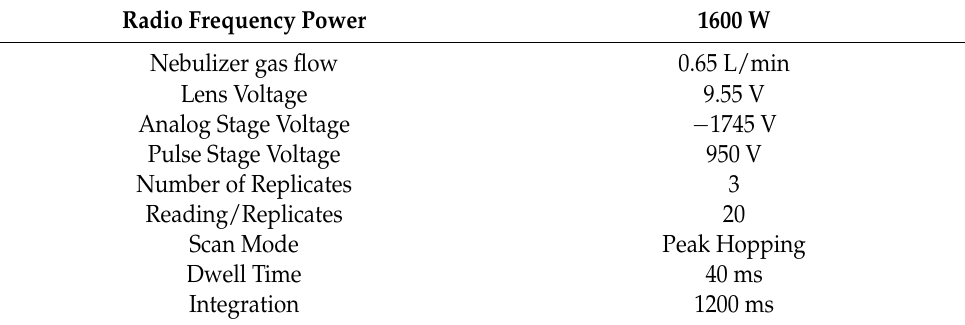
Table 3. Operating conditions of the